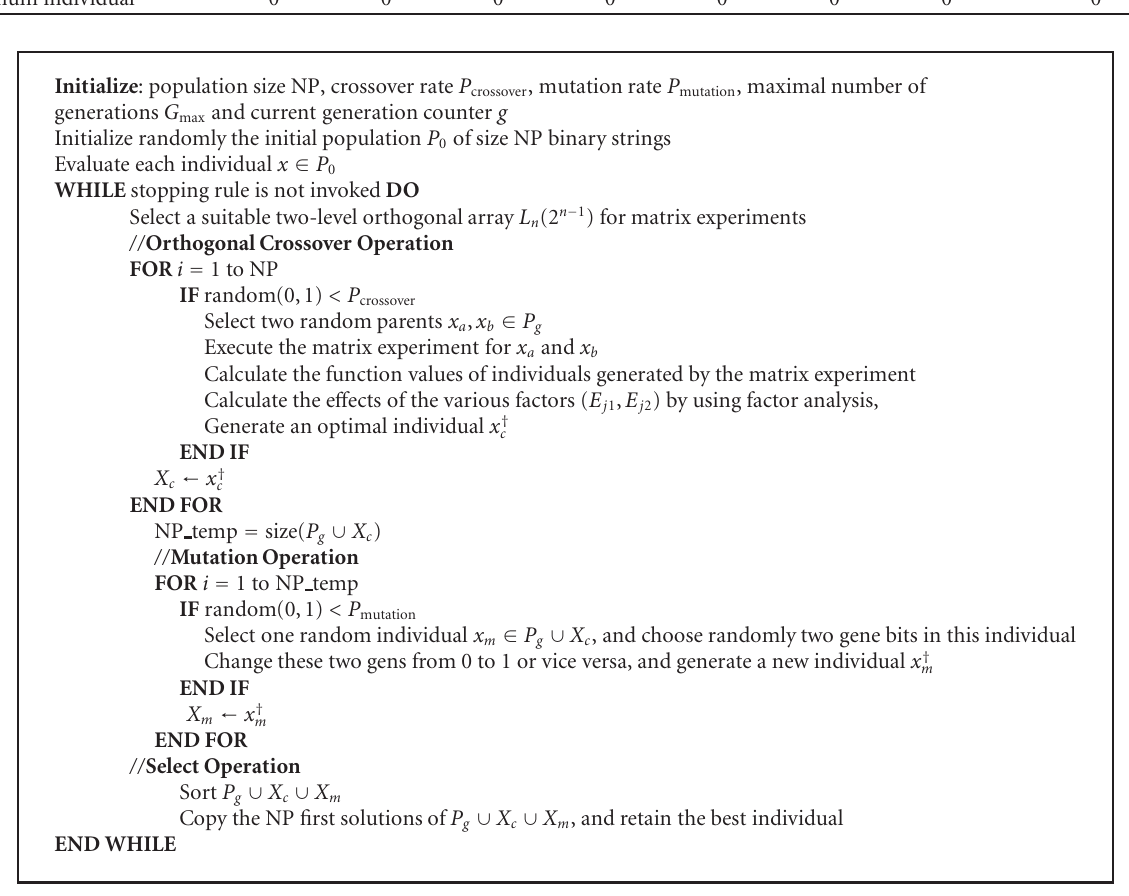
Algorithm 1: The pseudocode of